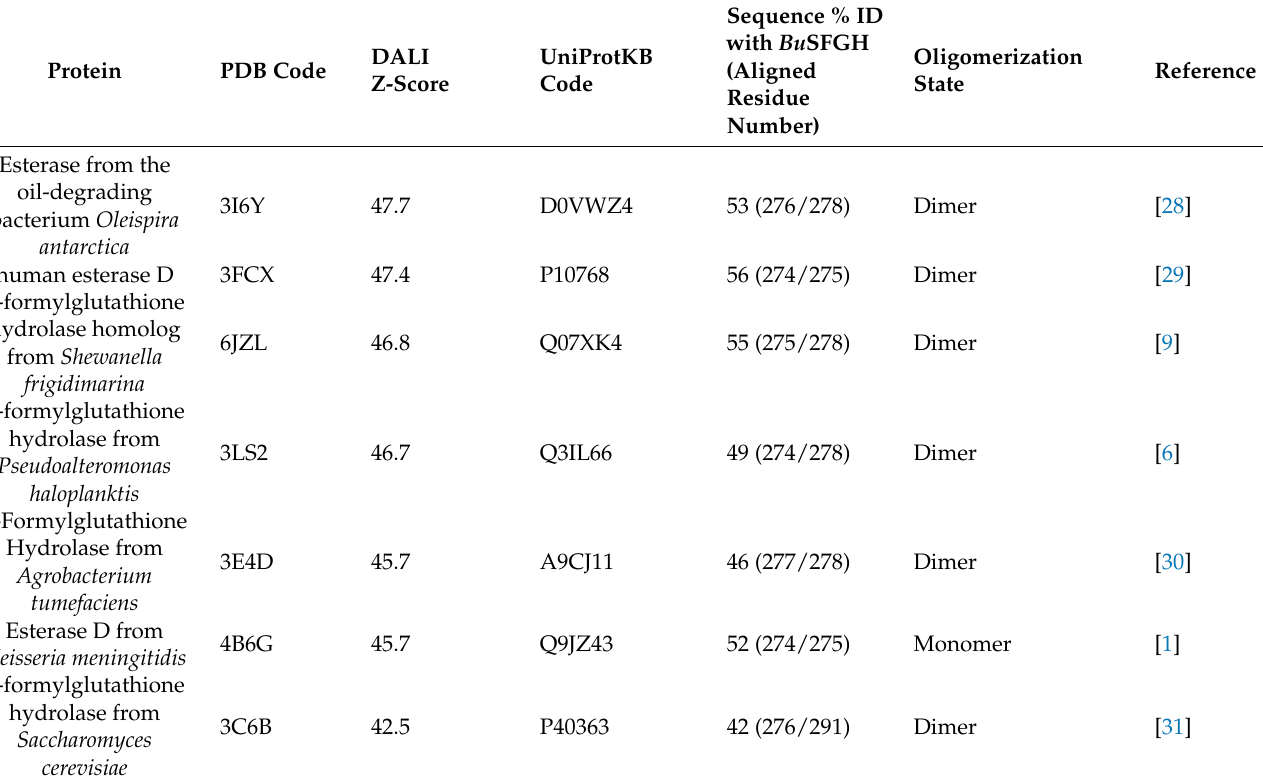
Table 2. Structural homolog search results for Bu SFGH, from a DALI search (DALI-Lite server).